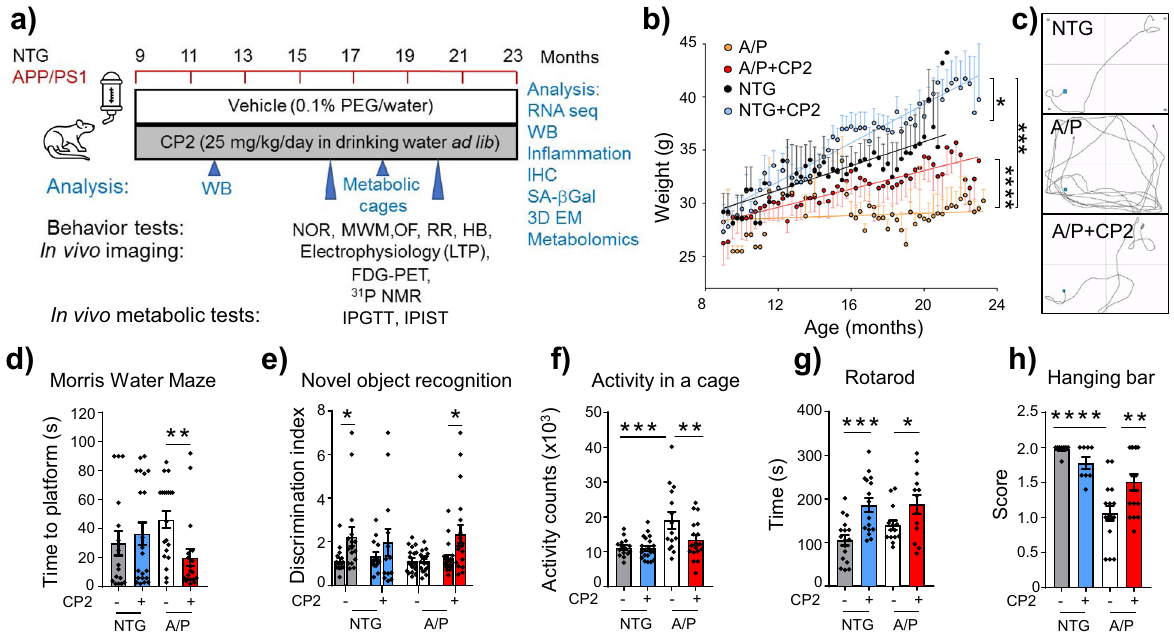
Fig. 2 CP2 treatment restores cognitive function in symptomatic APP/PS1 mice. a Timeline of chronic CP2 treatment. b Weight of NTG and APP/PS1 mice treated with vehicle or CP2 through the duration of the study. c – h CP2 treatment improves a performance in the Morris Water Maze ( c , d ) and in the Novel Object Recognition test ( e ), reduces hyperactivity of APP/PS1 mice in the open fi eld ( f ), and increases motor strength and coordination on the rotating rod ( g ) and hanging bar ( h ). NTG, n = 16 mice per group; NTG + CP2, n = 20 mice per group; APP/PS1, n = 21 mice per group; APP/PS1 + CP2, n = 19 mice per group. Data are presented as mean ± S.E.M. Data were analyzed by two-way ANOVA with Fisher ’ s LSD post-hoc test. A paired Student t -test was used for statistical analysis of NOR test. * P < 0.05, ** P < 0.01, *** P < 0.001, **** P < 0.0001. Body weight data in b were analyzed by linear regression analysis: Linear regression indicates that slopes between NTG ( R squared = 0.6821) and NTG + CP2 ( R squared = 0.9181) are different ( P = 0.0234); slopes between APP/PS1 ( R squared = 0.04326) and APP/PS1 + CP2 ( R squared = 0.7668) are different ( P < 0.0001); slopes between NTG ( R squared = 0.6821) and APP/PS1 ( R squared = 0.04326) are different ( P = 0.0005). In all graphs: APP/PS1, orange line; NTG, black line; NTG + CP2, blue line; APP/PS + CP2, red